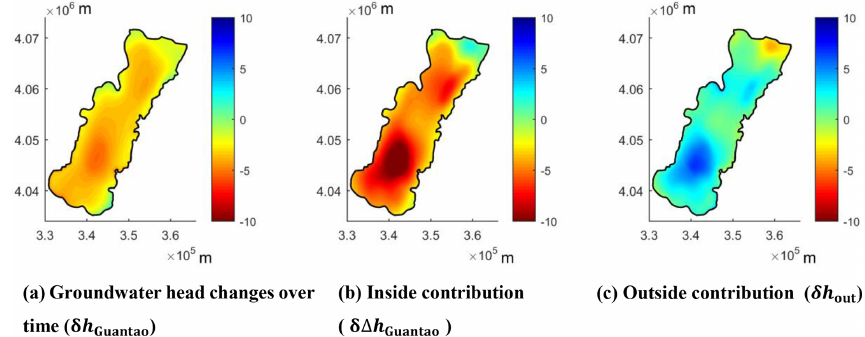
Figure 14. Spatial distribution of groundwater head change over the modeled time span and its decomposition: influence of decreased pumping rate.